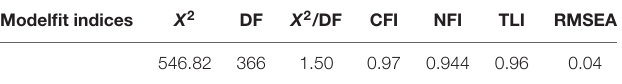
TABLE 2 | Model fit statistic.